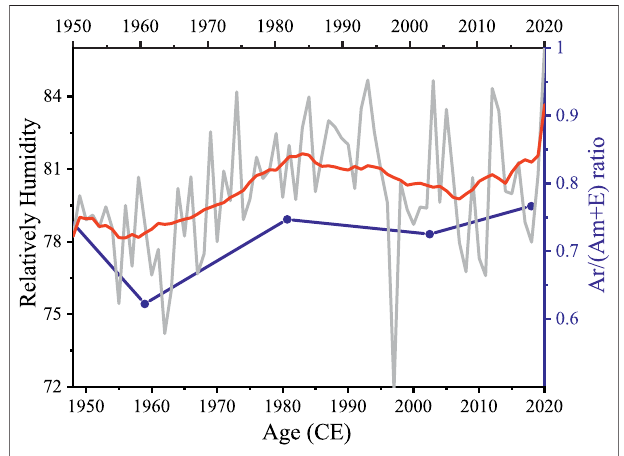
FIGURE 4 | Comparison of Ar/(Am + E) for the core JL18-02-A with variousRelativeHumidityrecordsfromtheFuhaistation(datafromhttps://psl. noaa.gov/data/index.html): grey line: relative humidity; red line: relative humidity result of 25-point smoothing; blue dot line: Ar/(Am + E) ratio.